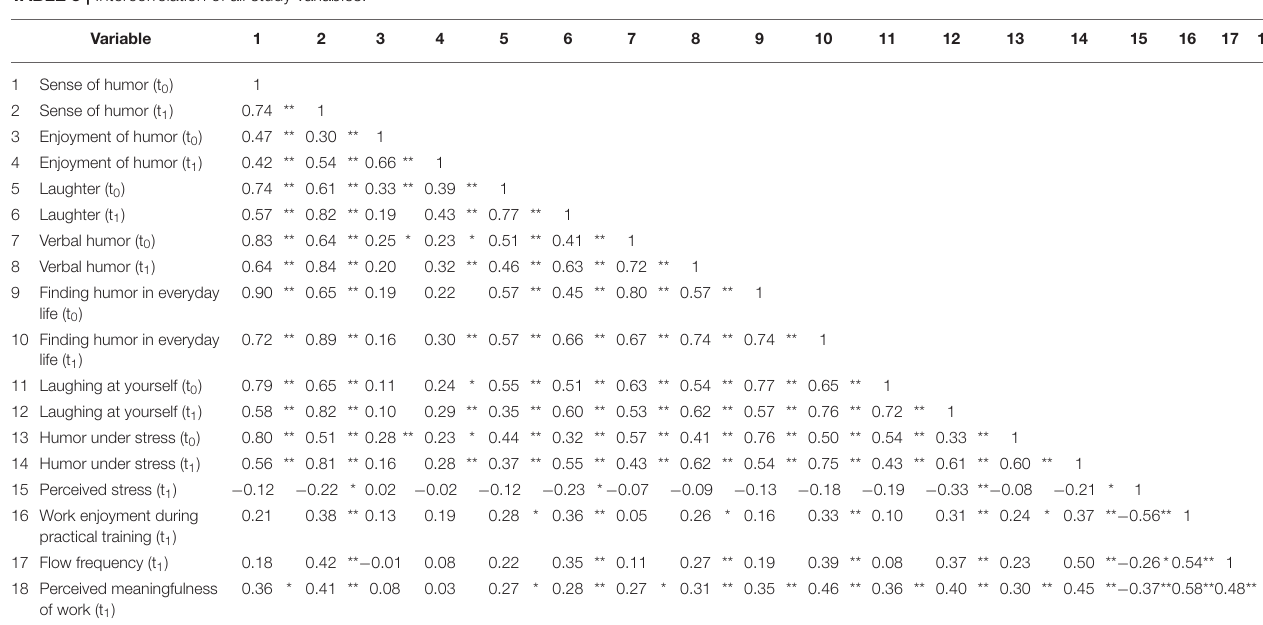
TABLE 3 | Intercorrelation of all study